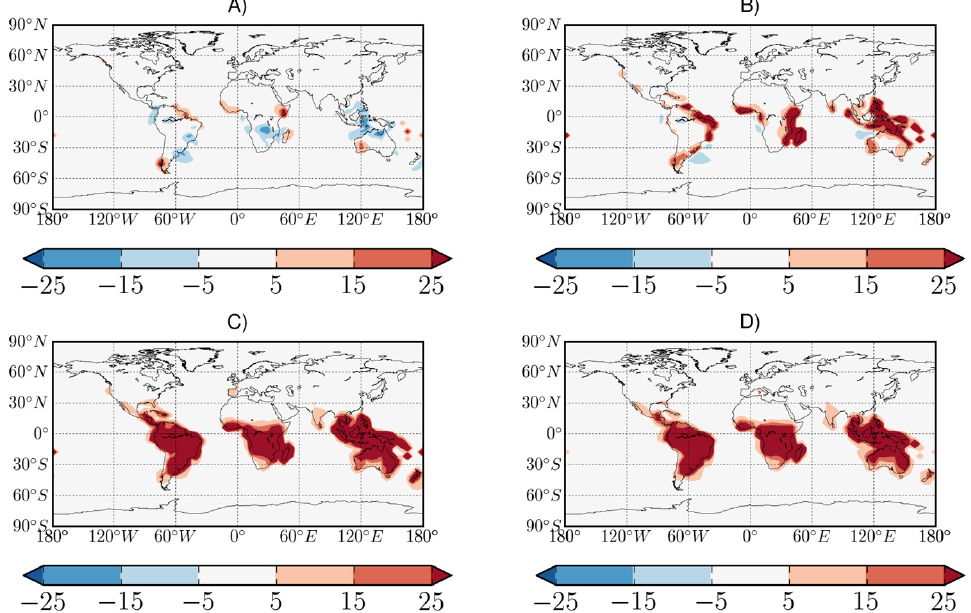
Fig. 10. Increases in aerosol number concentrations due to ultrafine aerosol growth by semi-empirical organic condensation scheme for March 2001. Changes in global aerosol number concentrations (average over 1km) if 50% of the total OA mass is distributed as effectively non-volatile, as compared with the case where is partitions to the pre-existing aerosol mass. The colorscale indicates percentage changes in number concentrations of particles > 3nm (A) , > 10nm (B) , > 40nm (C) , and > 80nm (D)